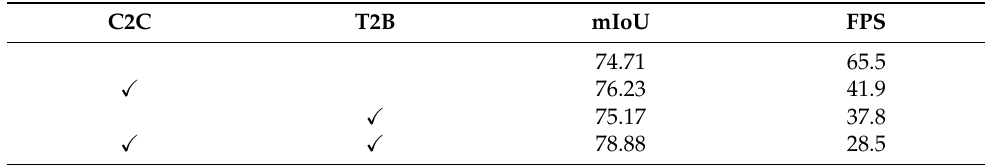
Table 3. Comparison of the Attentional